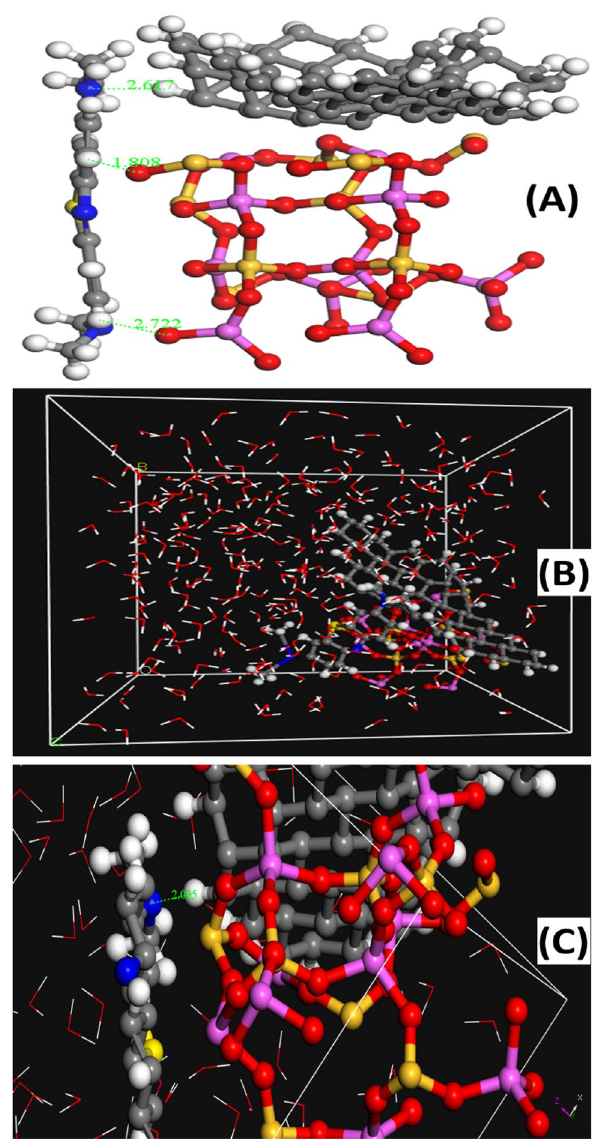
Figure 11. The ( A ) adsorption configurations and ( B ) simulation conformation of the MB dye adsorbed on the AC/NZ nanocomposite surface, obtained from MC simulation; and ( C ) MD snapshots at 5000 ps of the adsorption of methylene blue dye on the AC/NZ nanocomposite surface, the bond length is in Angstroms.